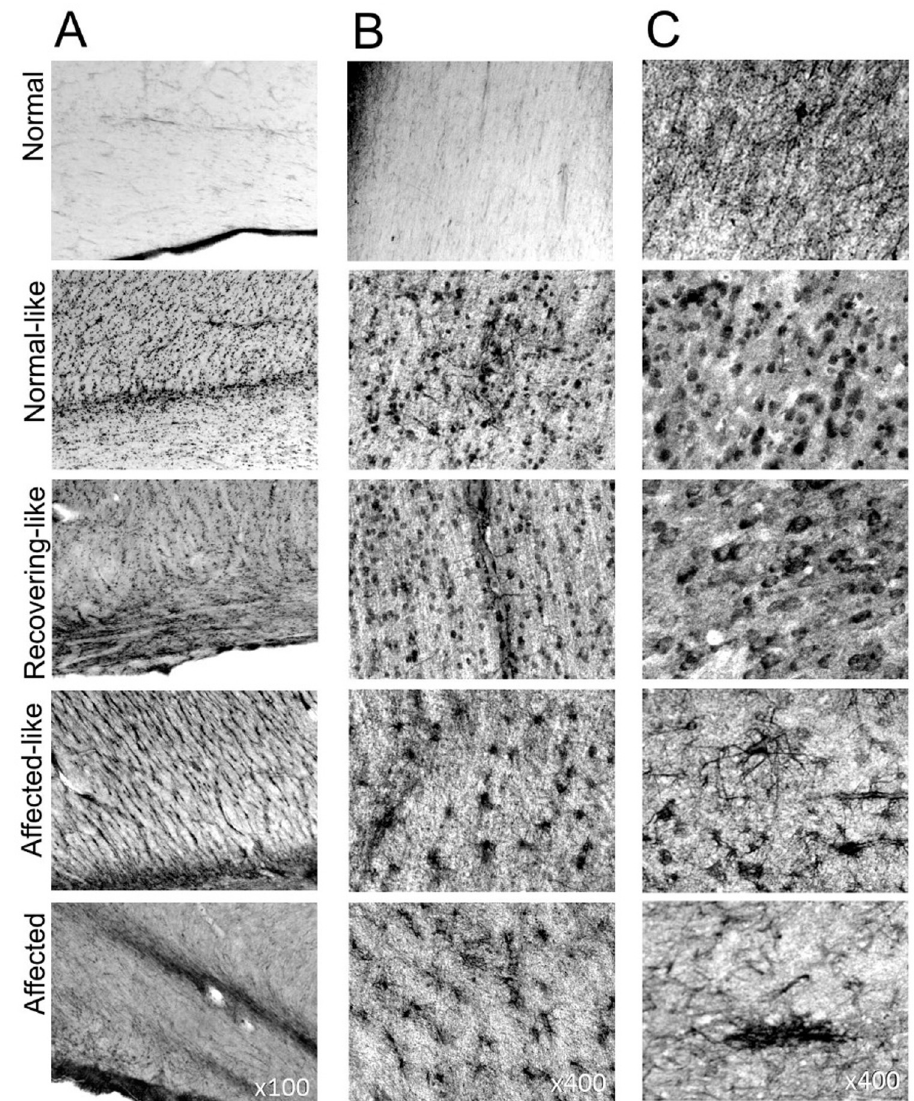
Fig 7. Neurogenesis in the sheep brain. Representative images of PSA-NCAM staining along the SVZ (A) and within the white matter (B) and grey matter (C) of control and chimeric animals. A band of newly generated and migratory cells are visible along the SVZ (A) in severely affected animals but not in normal controls. Staining is significantly increased along this region in all chimeric animals compared to normal controls and cells can be seen migrating along white matter tracts (B) towards the cortex (C). Large cellular aggregates are prominent within layer II of the grey matter in affected animals whereas chimeras display newly generated cells dispersed throughout all cortical layers. See S3 Fig for all